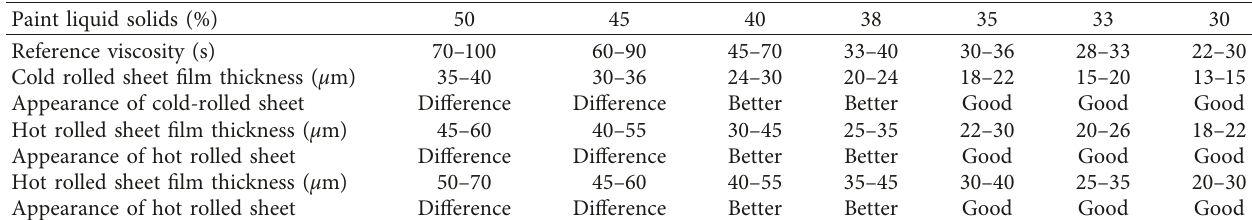
Table 1: Effect of paint liquid solid content on paint film appearance and film thickness (25 ° C).